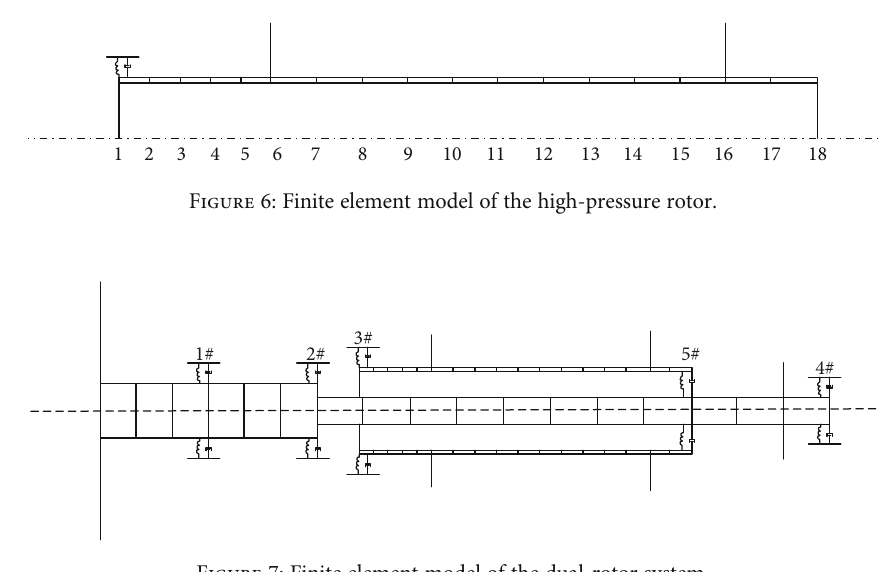
Figure 7: Finite element model of the dual-rotor